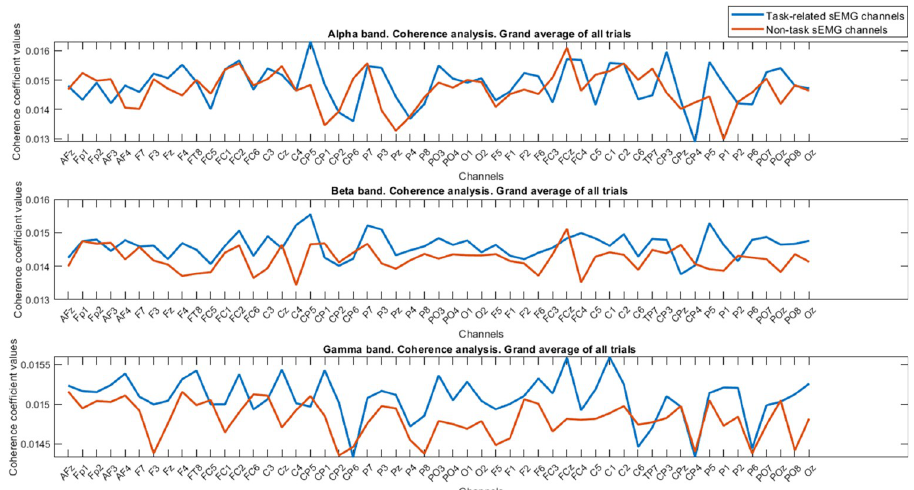
Fig 5. The results of coherence analysis for each specific band are described for all trials. Row 1 shows the alpha band coupling values, row 2 is dedicated to beta band coupling values, and row 3 refers to the gamma band coupling